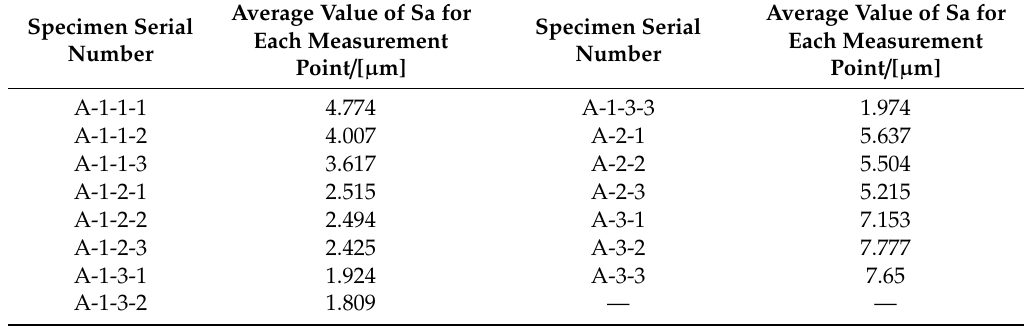
Table 3. Surface roughness of the steel sheet in the first group undergoing di ff erent surface treatments. Specimen Serial